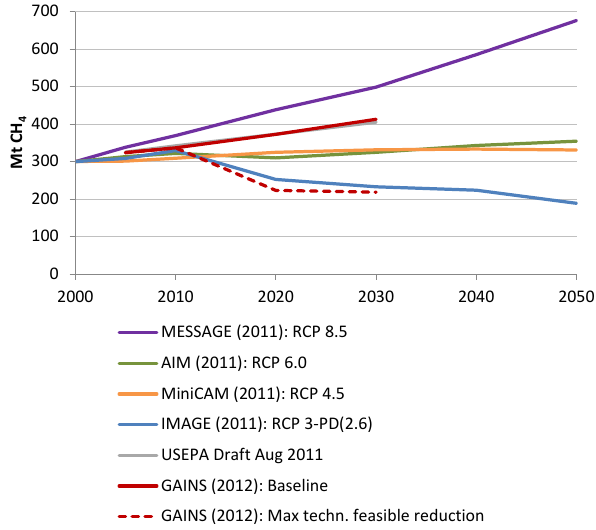
Fig. 9. Projection of baseline global anthropogenic CH 4 emissions in GAINS and in comparison to other models.